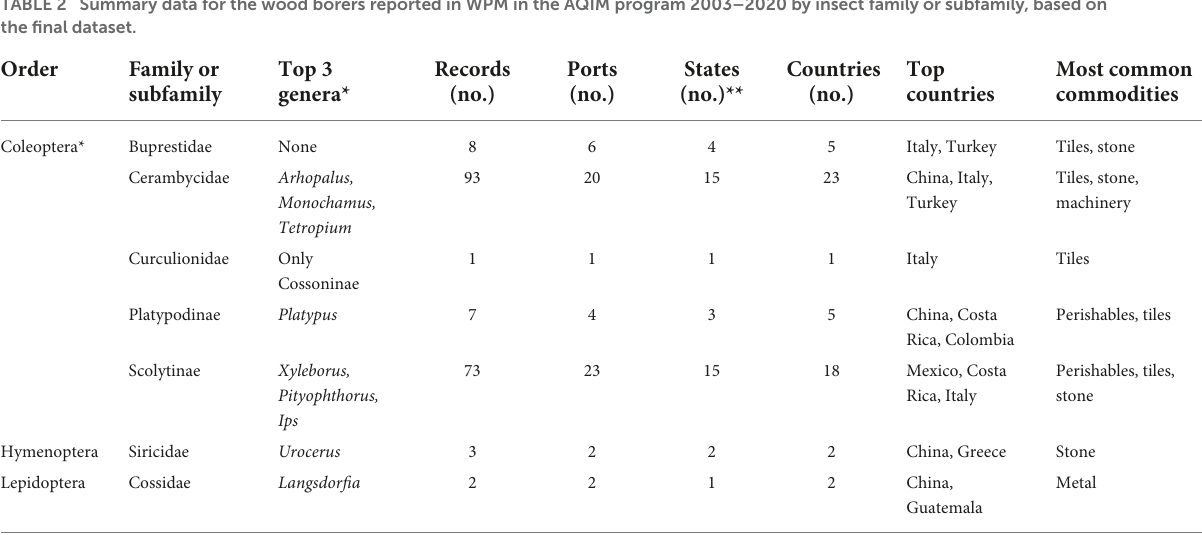
*PlatypodinaeandScolytinaetreatedseparatefromCurculionidae.**PuertoRicowastreatedasaUSstateinthisTable,withthreewoodborerrecordsinWPMmadeatthemaritimeport ofSanJuan,PR(1cerambycid,1platypodine,and1scolytine). TABLE 3 Summary data for the wood borers intercepted in WPM at US ports during four time periods from 2003 to 2020, based on the final dataset.